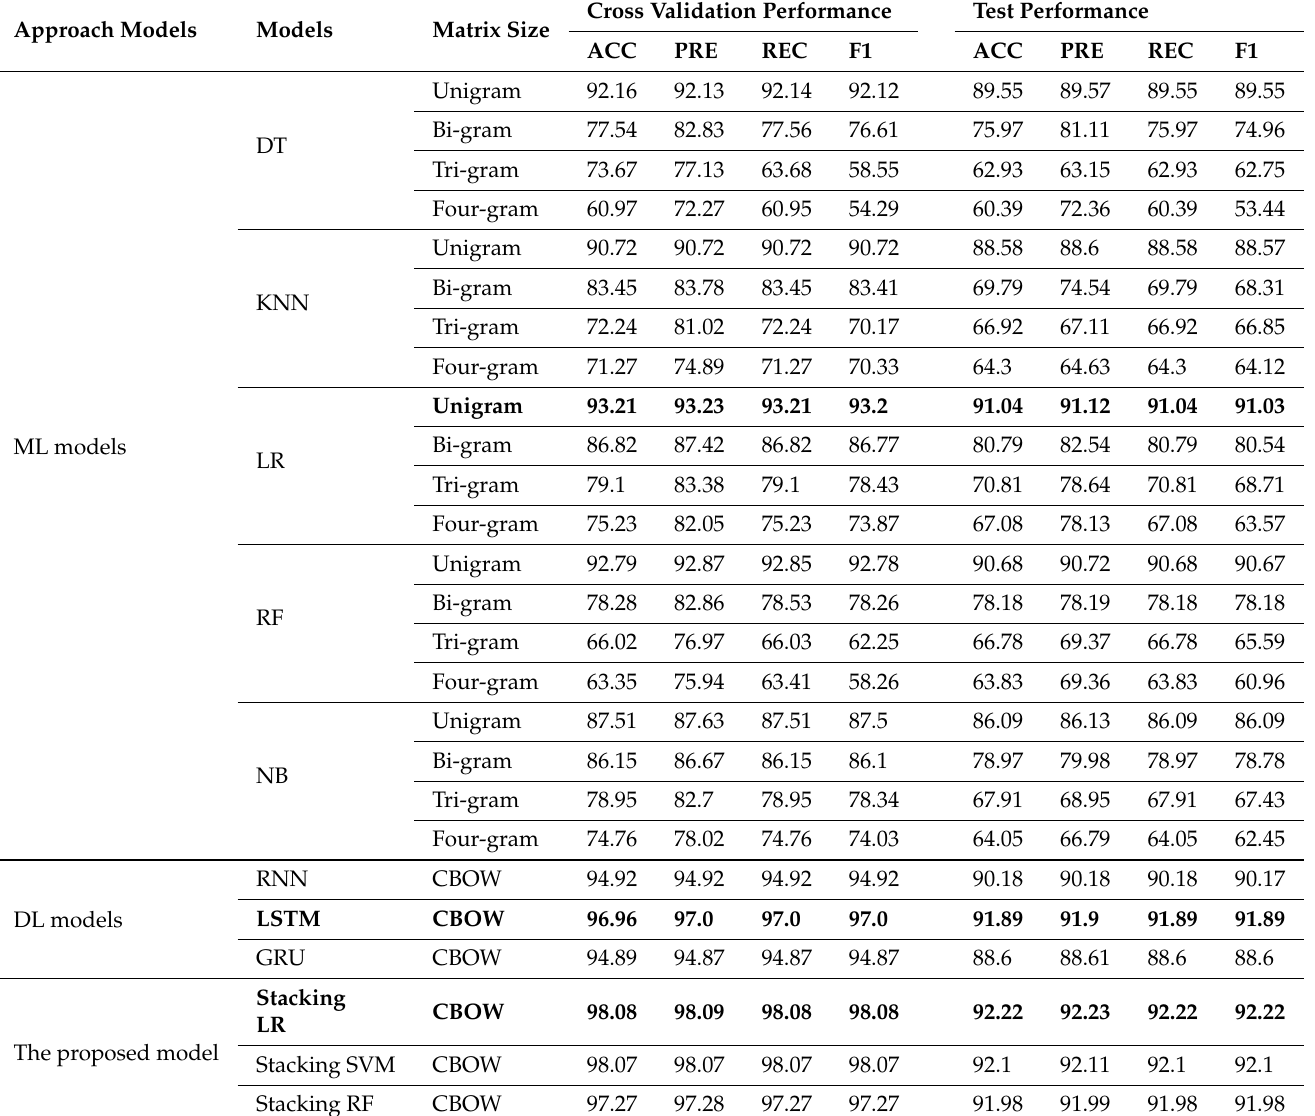
Table 2. The performance results of ML, DL, and the proposed models for ASTC dataset. Approach